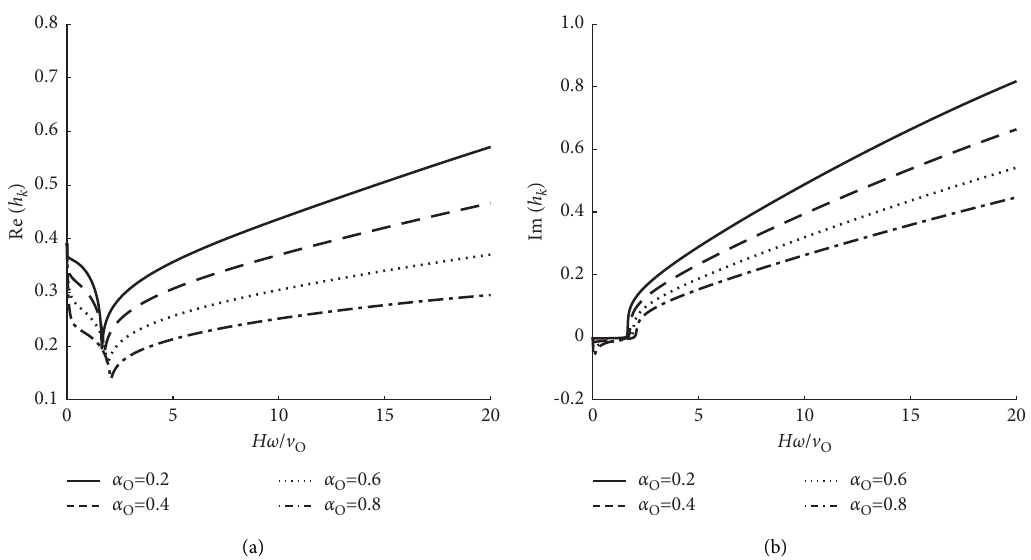
Figure 4: The impedance factor curves of pile around soil under different fractional derivative orders. (a) Horizontal stiffness factor of the soil layer. (b) Horizontal damping factor of the soil layer.